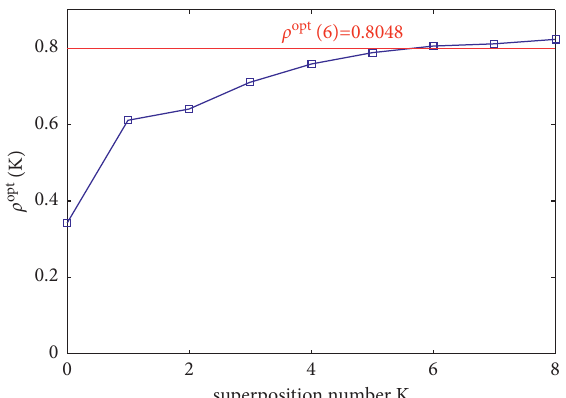
Figure 17: The variation curve of ρ opt ( K ) with the increase of the superimposition number K .